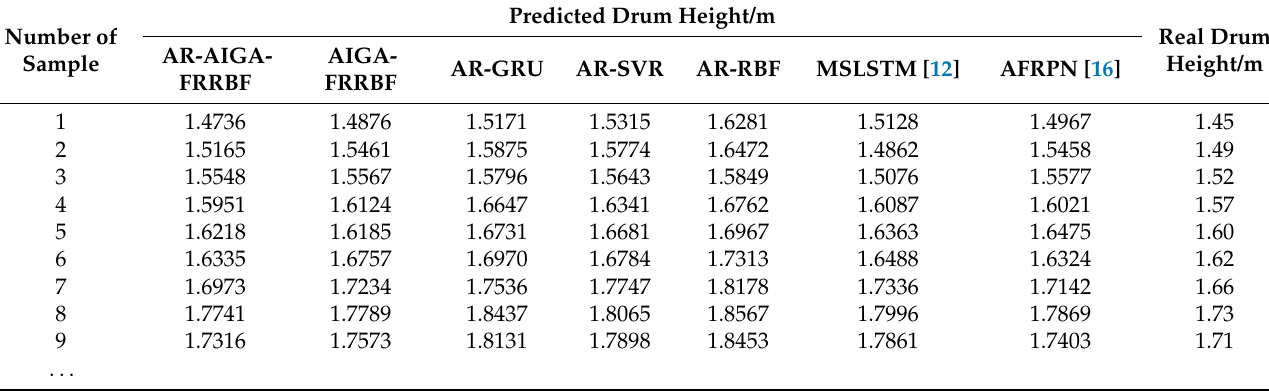
Table 11. Predicted height of the training sample of the right drum of the